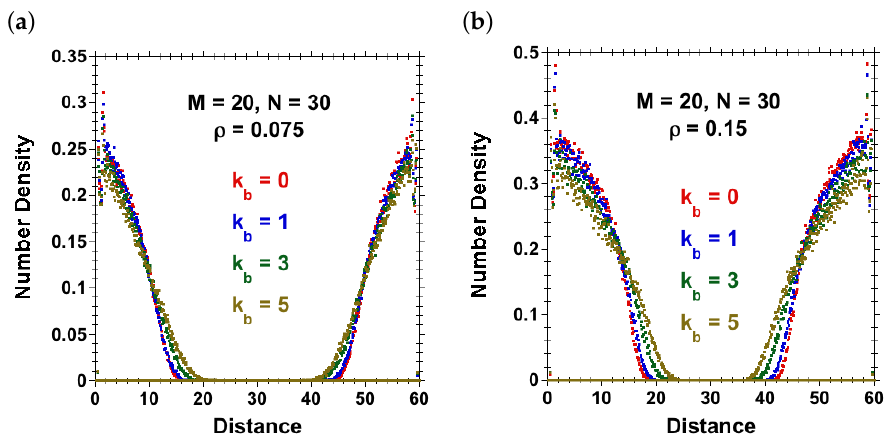
Figure 3. Polymer concentration profiles for non-interacting, opposing brushes at two grafting densities ( a ) ρ = 0.075 and ( b ) ρ = 0.15 for chains of various values of bending stiffness k b ( M = 30 chains with N = 30 on each side). Brush heights shown in Figure 4 are extracted from these profiles.